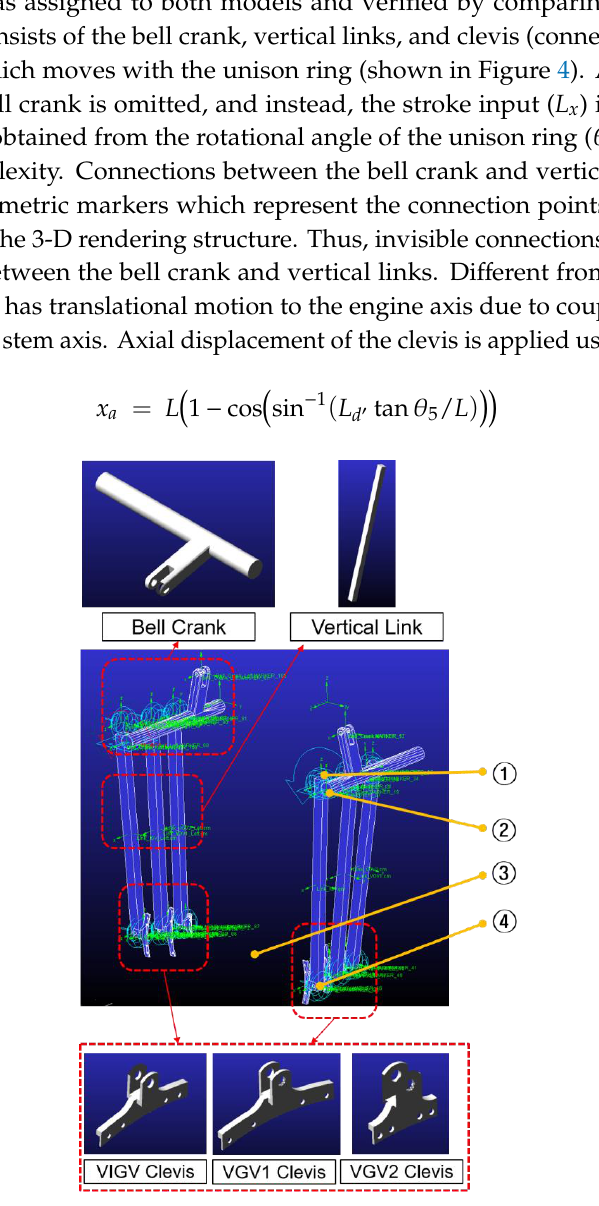
Figure 4. Layout of the Adams Mechanistic Model .